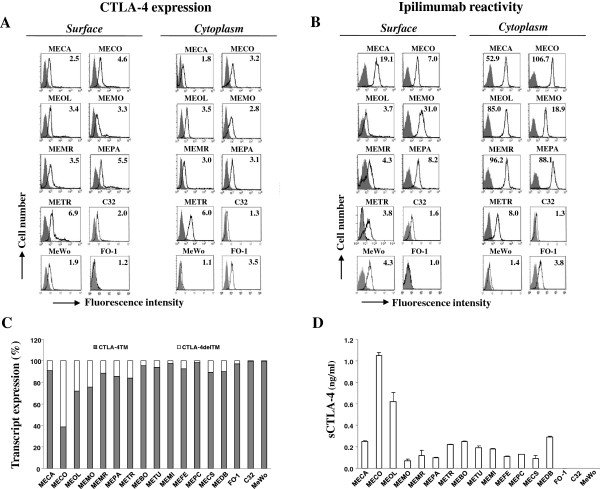
CTLA-4 is expressed in cutaneous melanoma cell lines and it is recognized by Ipilimumab. Flow cytometric profiles of representative primary cell lines and established cell lines (C32, MeWo, FO-1), stained with either an anti-CTLA-4 polyclonal antiserum (surface) and 14D3 mAb (cytoplasm) (panel A) or Ipilimumab Ab (panel B). FO-1 cell line was used as control for CTLA-4 surface negative expression. Open histograms represent staining with specific anti-CTLA-4 Abs, filled histograms represent staining with isotype control Abs. Numbers within the quadrants represent values of MRFI. Panel C, densitometric analysis of RT-PCR for CTLA-4 transcripts (TM and delTM) normalized to GAPDH and reported as % of expression. The experiment was repeated three times with similar results. Panel D, ELISA analysis of sCTLA-4 in melanoma cell SN. Results are means ± SD of two independent experiments performed in duplicate.